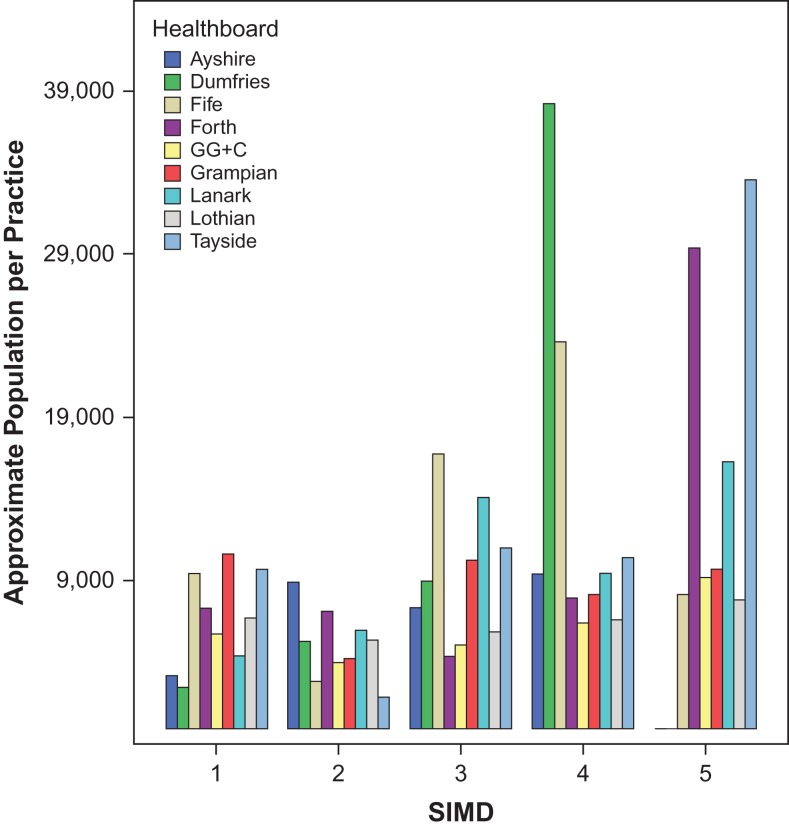
Approximate population per practice. Ayshire and Dumfries have no practices with Quintile 5 postcodes; as a result, there are seven bars for Quintile 5 in this figure (whilst the other four quintiles contain values for all nine included Health Boards). Health Boards are ordered alphabetically.